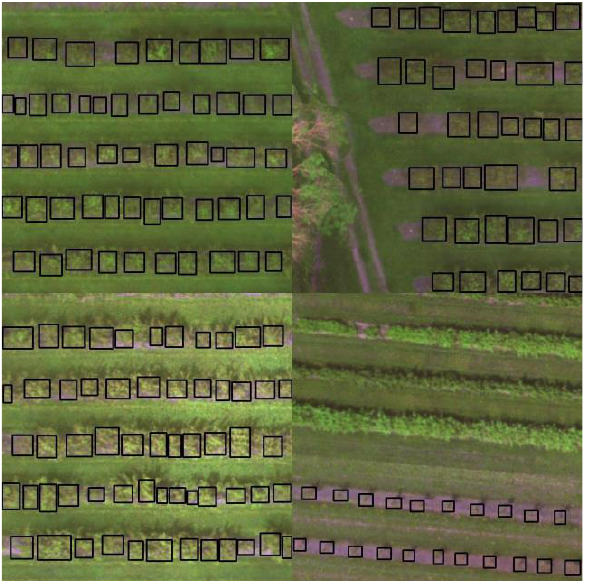
Figure 10 . Mosaic data augmentation technique.